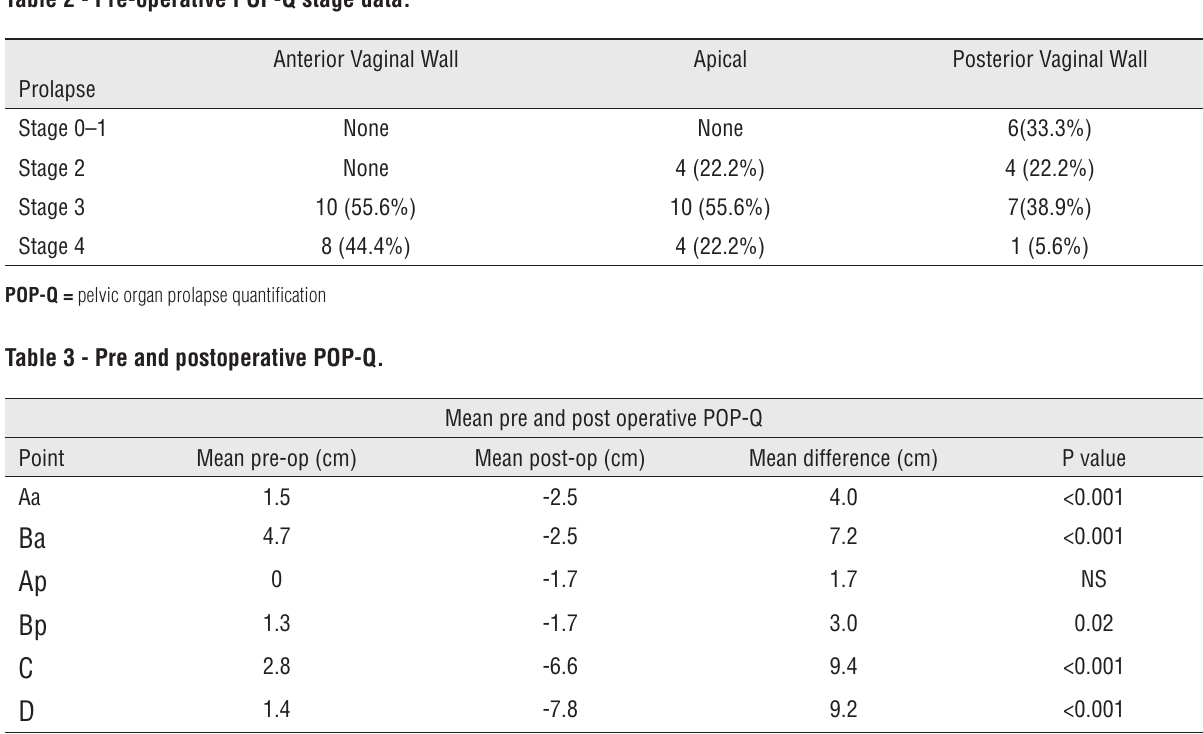
Table 2 - Pre-operative POP-Q stage data.